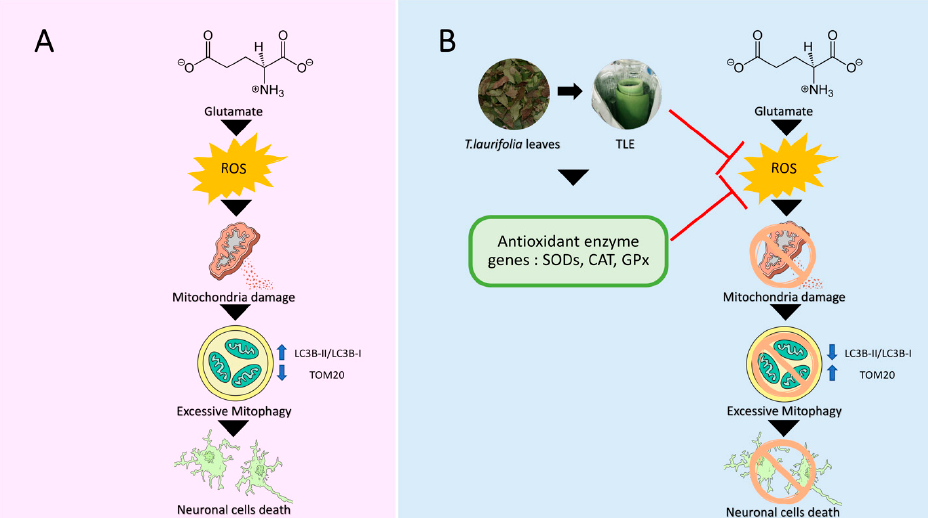
Figure 10. The summarized diagram of the neuroprotective effect and mechanism of TLE against glutamate-induced neuronal death in HT-22 cells through cellular antioxidants and mitophagy signaling. ( A ) The accumulation of glutamate in neurons leads to the rise in intracellular ROS. The high ROS can destruct the mitochondria and stimulate the excessive selective autophagy of damaged mitochondria (mitophagy), resulting in neuronal cell death. On the other hand, ( B ) TLE can directly neutralize the ROS and upregulate the gene expression of antioxidant enzymes. These two mechanisms completely inhibit ROS activity and rescue the mitochondrial health. Moreover, TLE can decrease the mitophagy activation, causing a decrease in neuronal cell death.